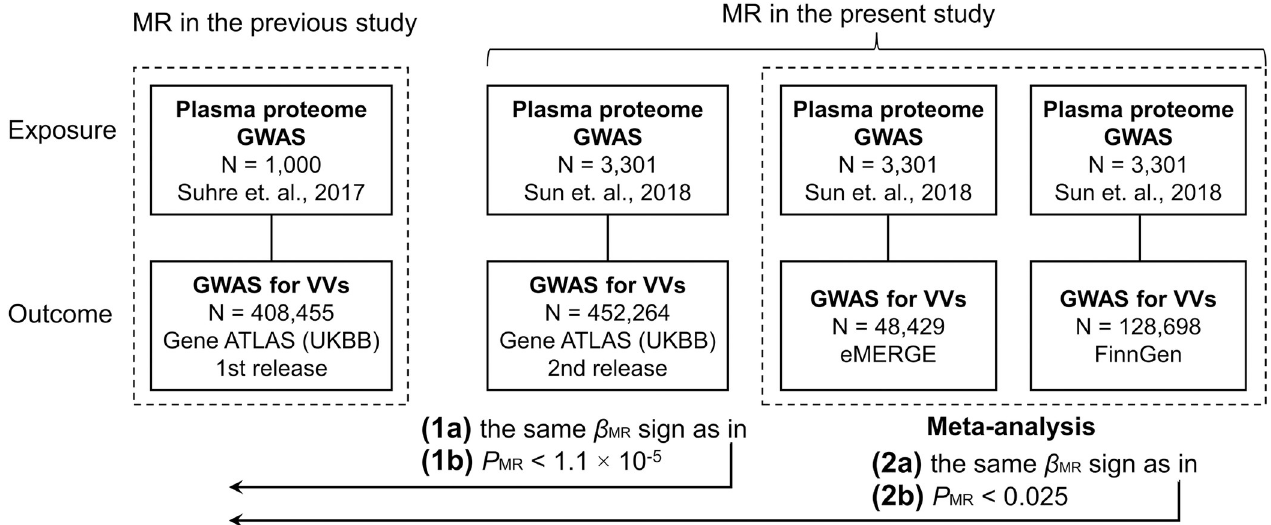
Fig 1. Criteria for statistically significant and replicated results used in the present study. GWAS, genome-wide association study; MR, Mendelian randomization; P , P -value; UKBB, UK Biobank; VVs, varicose veins of lower